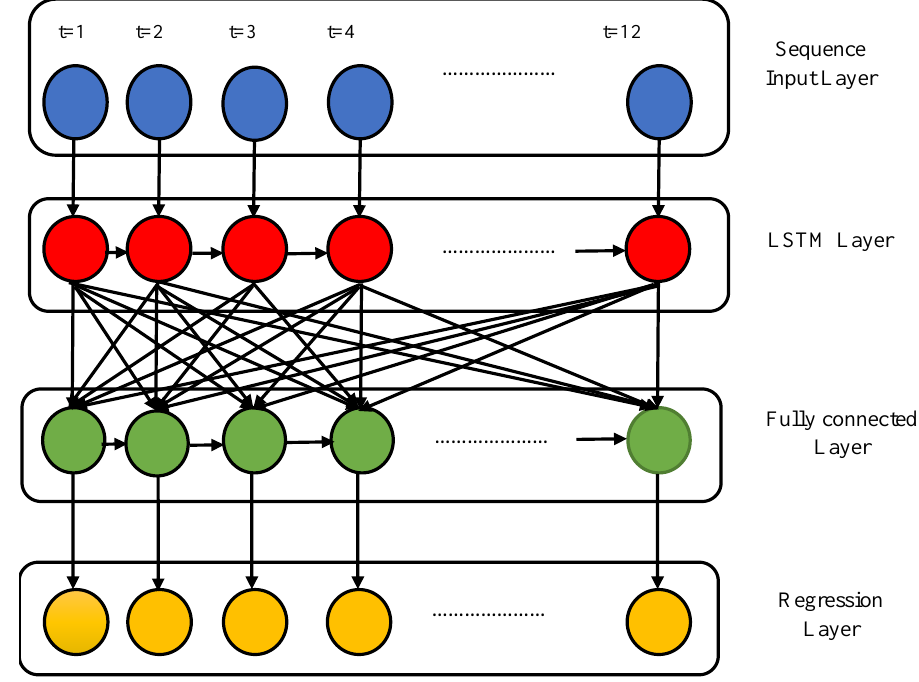
Figure 3. The layered structure of proposed RNN-LSTM model.